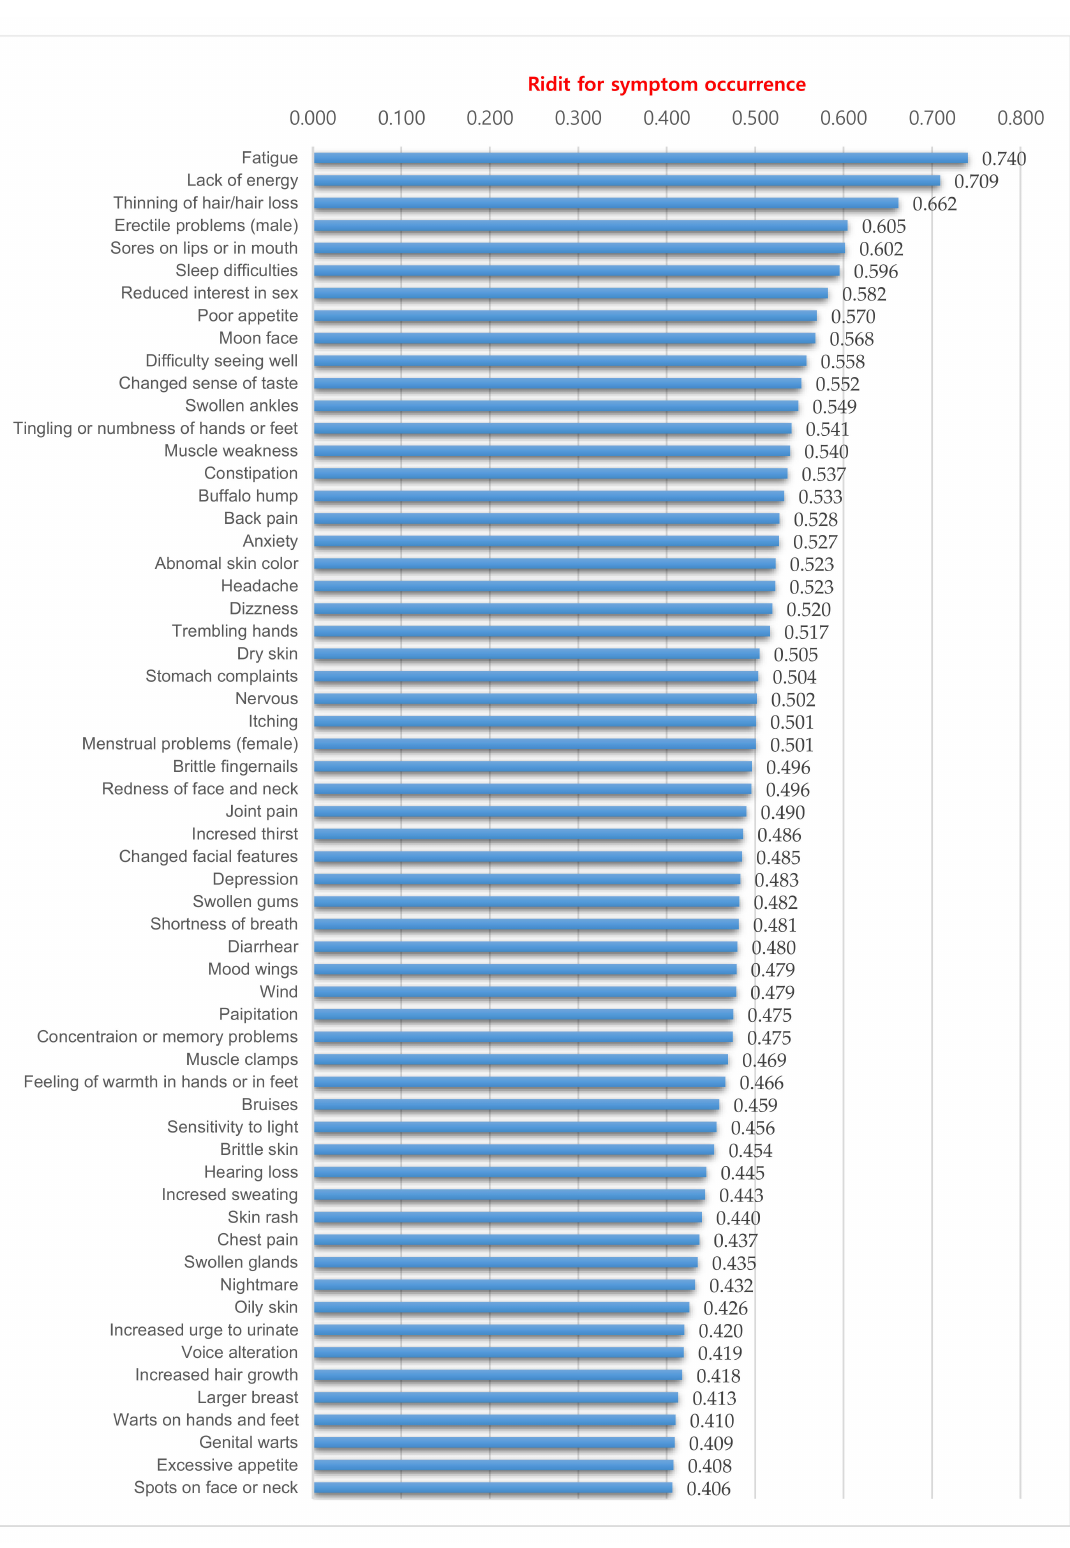
Figure 1. Distribution of symptom occurrence among all